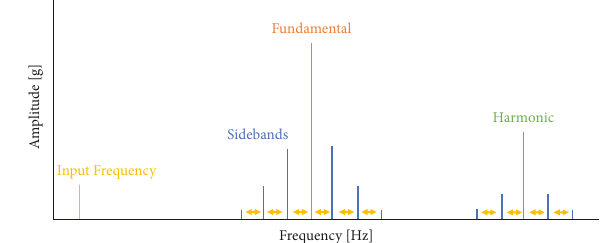
Figure 11: Difference in frequency spectrum regarding sampling technique for a speed-varying signal.